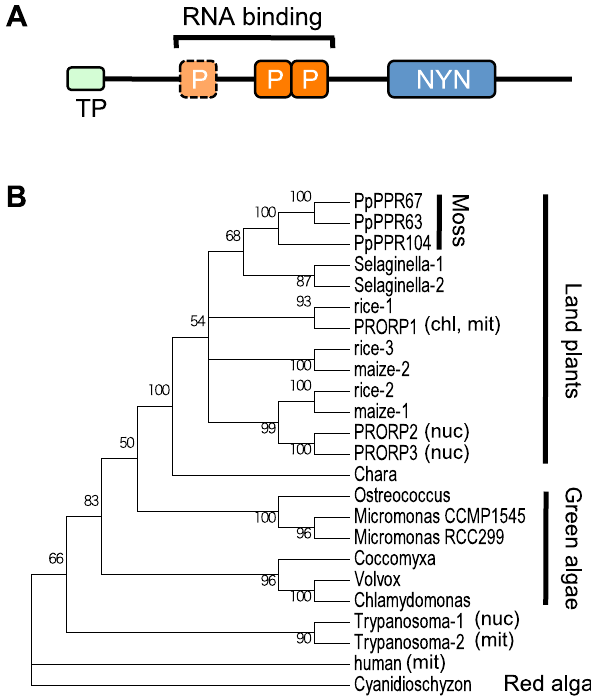
Figure 1. PRORP proteins are widely distributed among eukaryotes. ( A ) Schematic diagram of plant organellar PRORPs with a transit peptide (TP), RNA binding PPR motifs (P), and NYN metallonuclease domain (NYN). ( B ) Neighbor-joining phylogenetic tree of PRORPs and PRORP-like proteins. Representative PRORP protein sequences from evolutionarily distant plants were used for the phylogenic analysis. Experimentally determined localization of PRORPs is presented as chloroplast (chl), mitochondria (mit), or nucleus (nuc). Bootstrap values . 50 are indicated along branches. Protein ID or accession numbers of PRORPs and PRORP-like proteins are listed in Table S1.